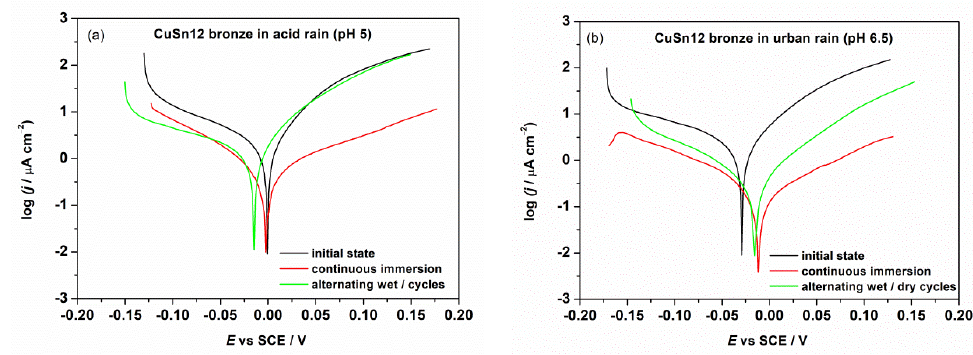
Figure 11. Polarization curves for CuSn12 bronze in ( a ) acid rain and ( b ) urban rain. Table 10. Corrosion parameters of sulphate patinated CuSn12 bronze obtained by Tafel extrapola- tion method.